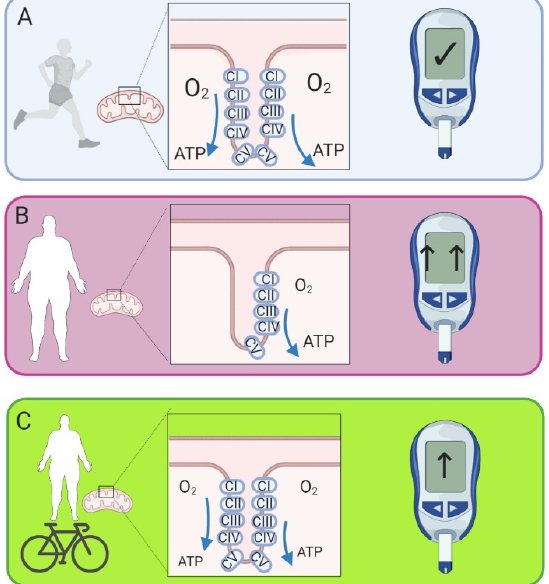
Figure 3. ( A ) Fit, healthy individuals have increased mitochondrial respiratory function and are insulin sensitive. ( B ) Patients with insulin resistance and type 2 diabetes (T2D) have